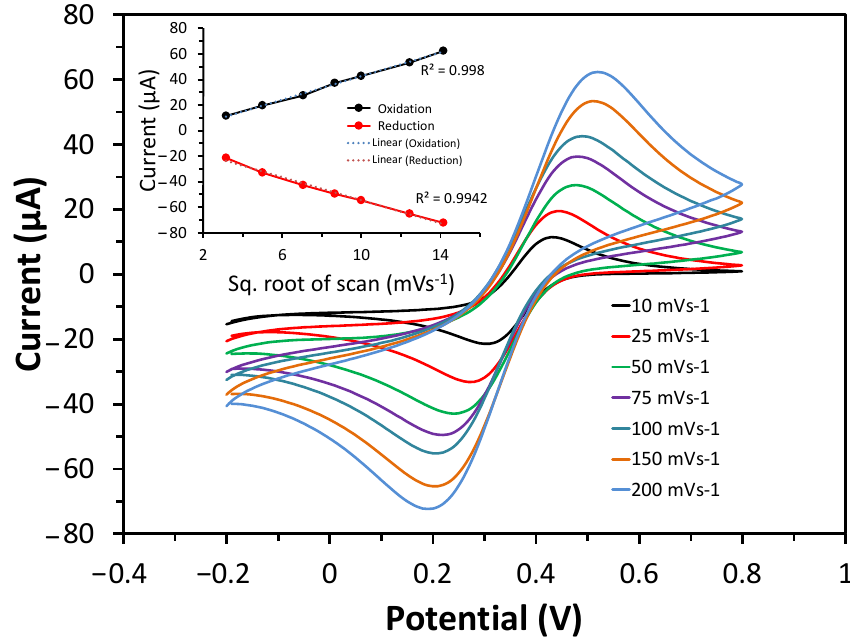
Figure 4. CV curve of cobalt oxide puffy balls nanostructures/GC electrode measured in probe solution from 10 to 200 mVs − 1 scan rates. Inset shows the anodic/cathodic current vs. square root of the scan rate plot.